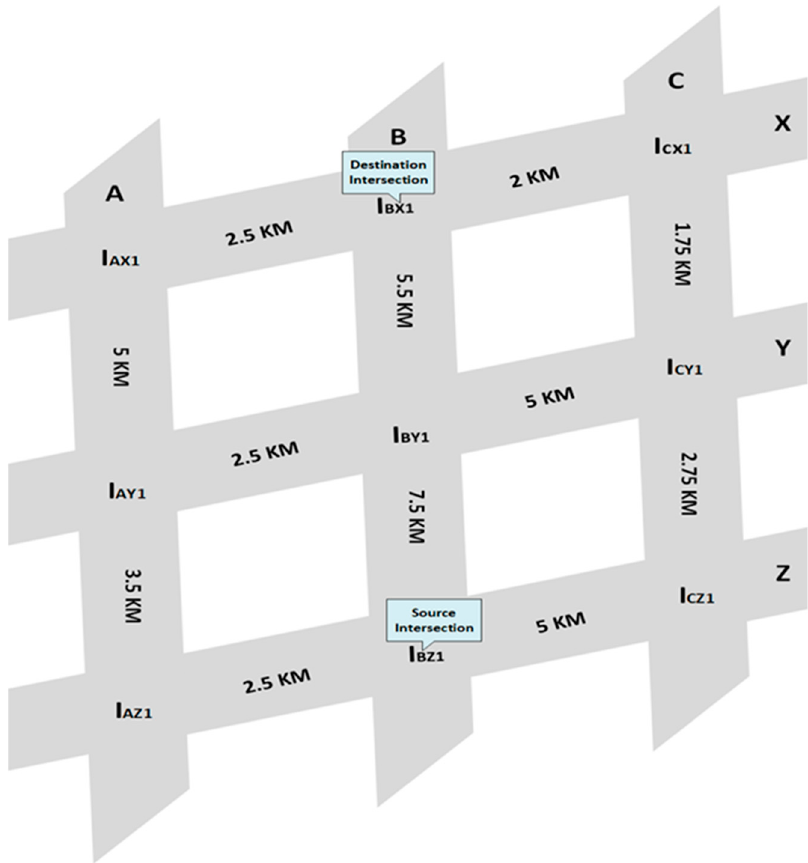
Figure 3. Shortest route discovery metric.